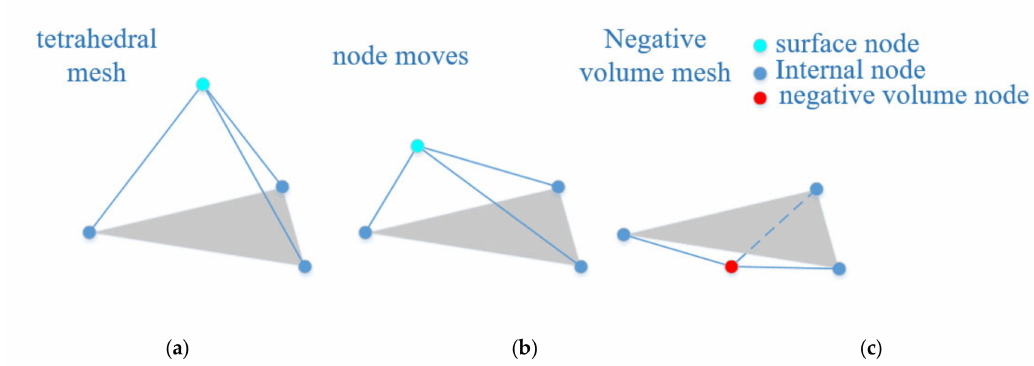
Figure 4. Schematic diagram of node displacement; ( a ) tetrahedron element ( b ) node displacement element ( c ) element of negative